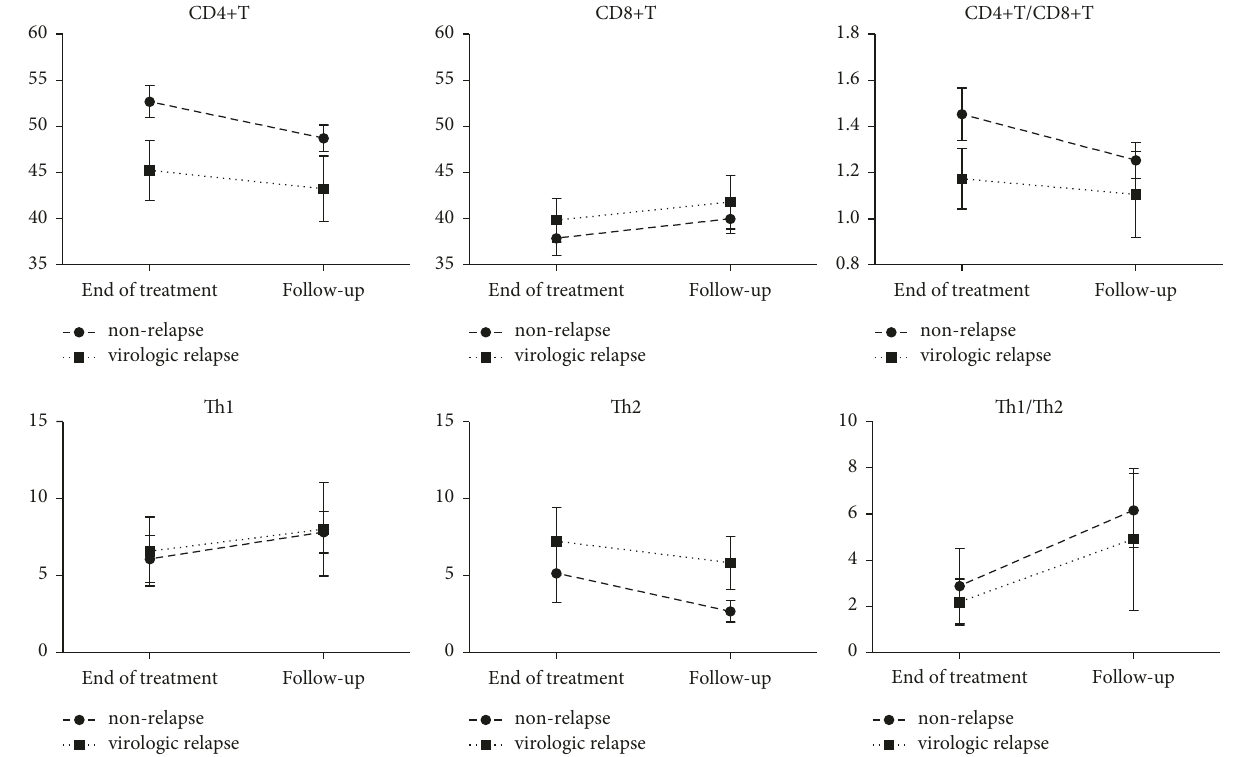
Figure 4: Changes in the ratios of CD4 + T, CD8 + T, Th1, and Th2 in nonrelapse and virologic relapse patients.